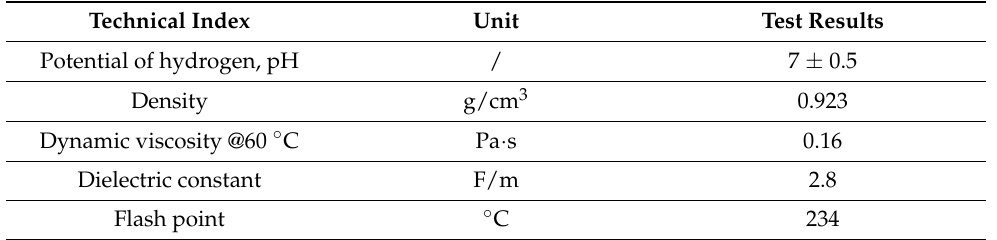
Table 3. Technical properties of the soybean